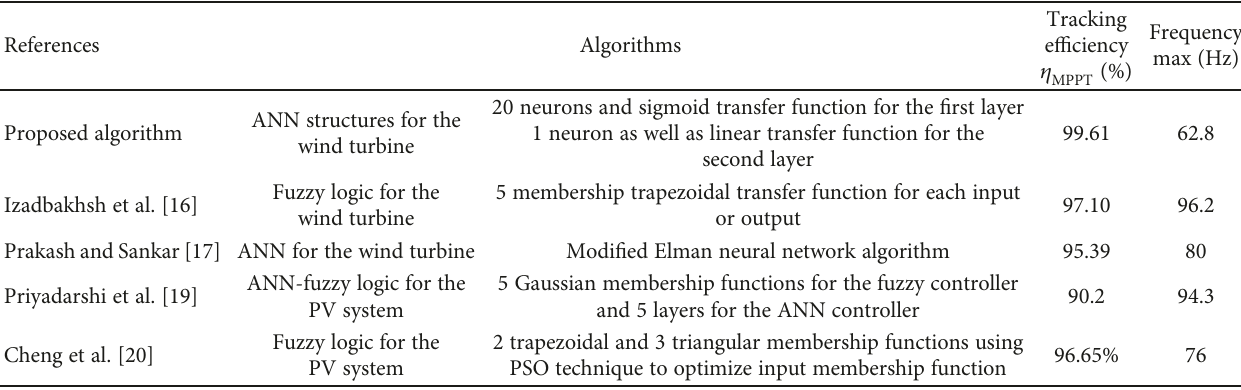
Figure 18: Power curves obtained with an ANN controller in Simulink and an ANN controller designed on XSG. Table 7: Performance comparison.